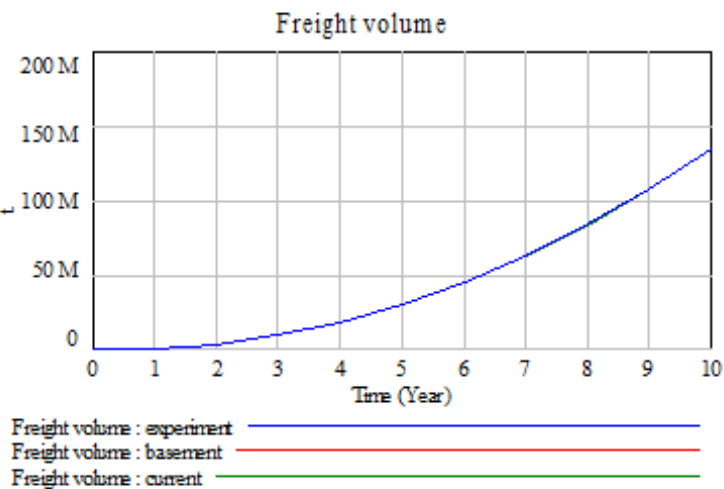
Figure 5. Experiment for freight volume with changes of ASCAV